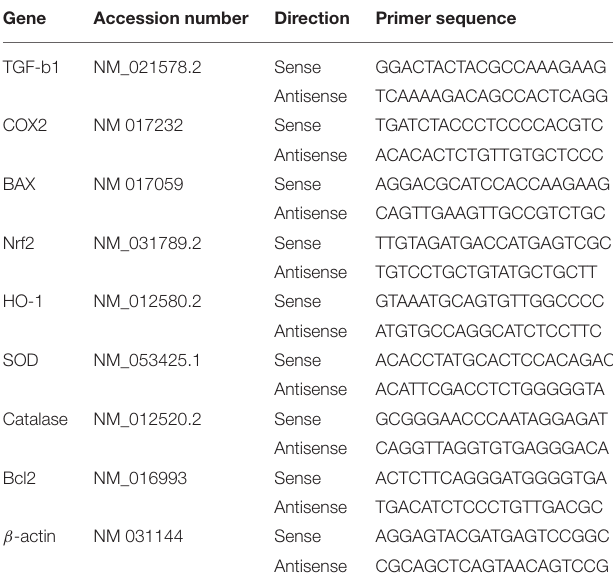
TABLE 1 | Primer sequences used for quantitative real time PCR in liver of